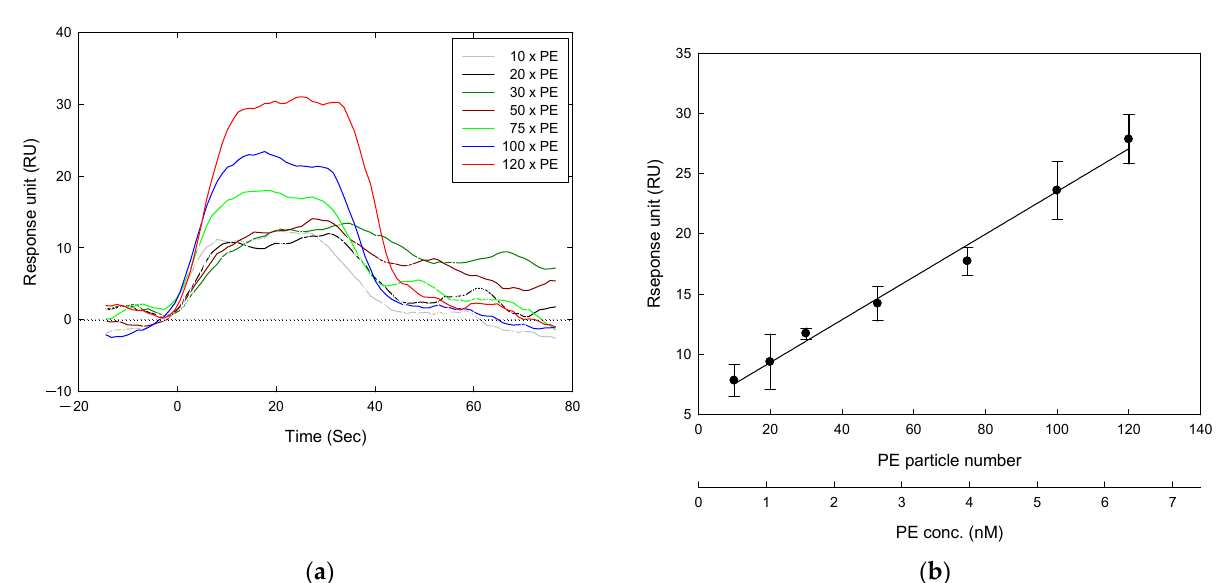
Figure 5. Calculation of micro-plastics concentration by SPR. When ERs were not immobilized on biosensors, various concentrations of PE micro-plastics flowed through, and the relationship between concentration and absorption was observed. ( a ) Raw data for micro-plastics and reaction intensity during reaction period. ( b ) The relationship between micro-plastics number/concentration and absorption was plotted; the absorption value was taken according to the point in ( a ). It can be seen that in the absence of estrogen receptors, the micro-plastics had a linear relationship with the relative absorption (response unit, RU). All data were repeated twice. Reaction volume: 30 μ L; reaction flow rate: 50 μ L/min.